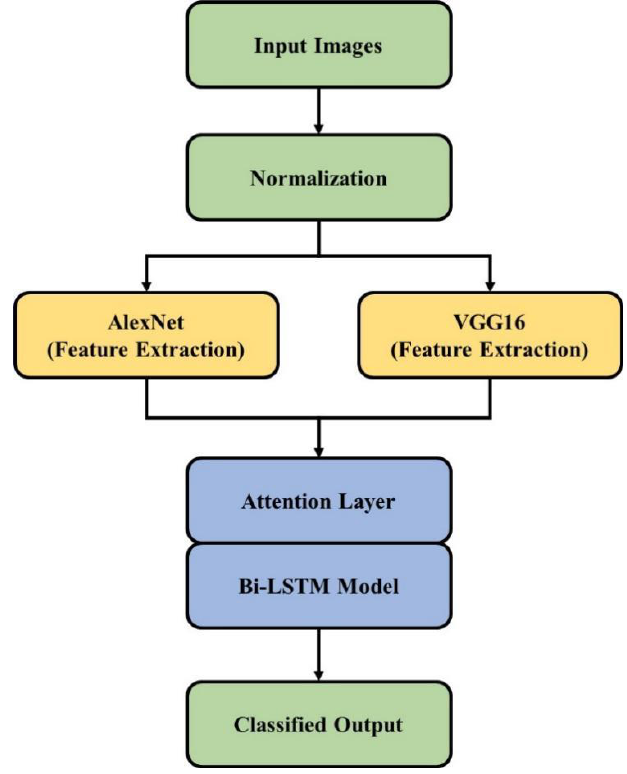
Figure 1. The FWA-BiLSTM model in change detection.